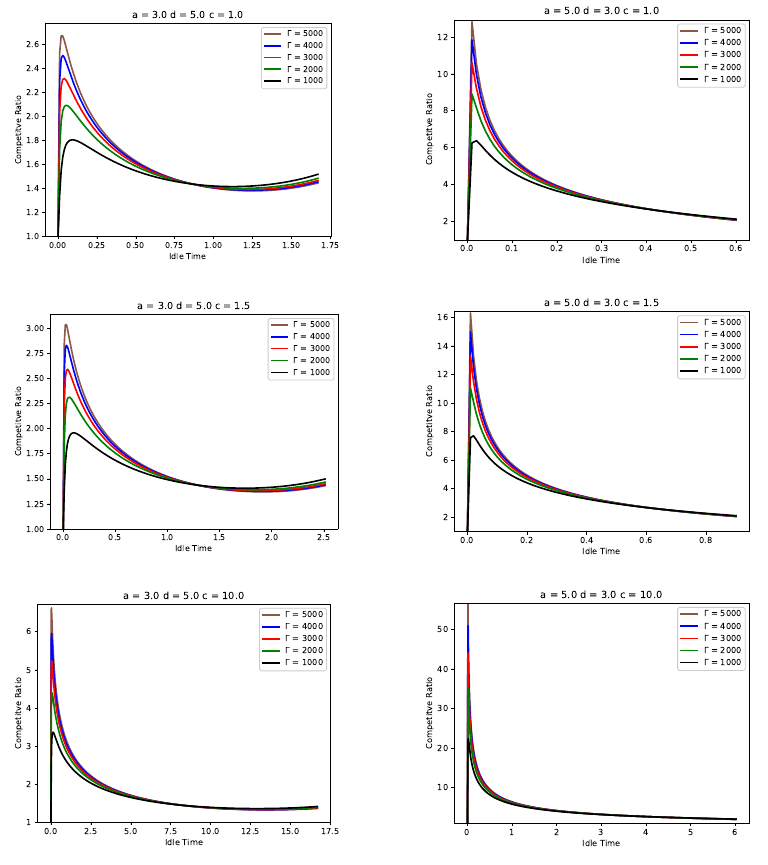
Figure A1. Simulations logarithmic strategies for various parameter